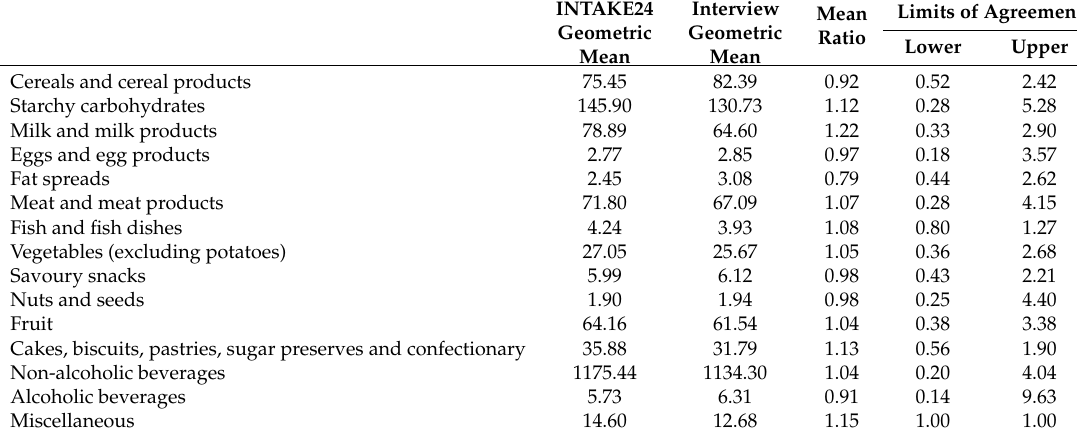
Table 5. Agreement of intakes of main food groups for 17–24 years old ( n =